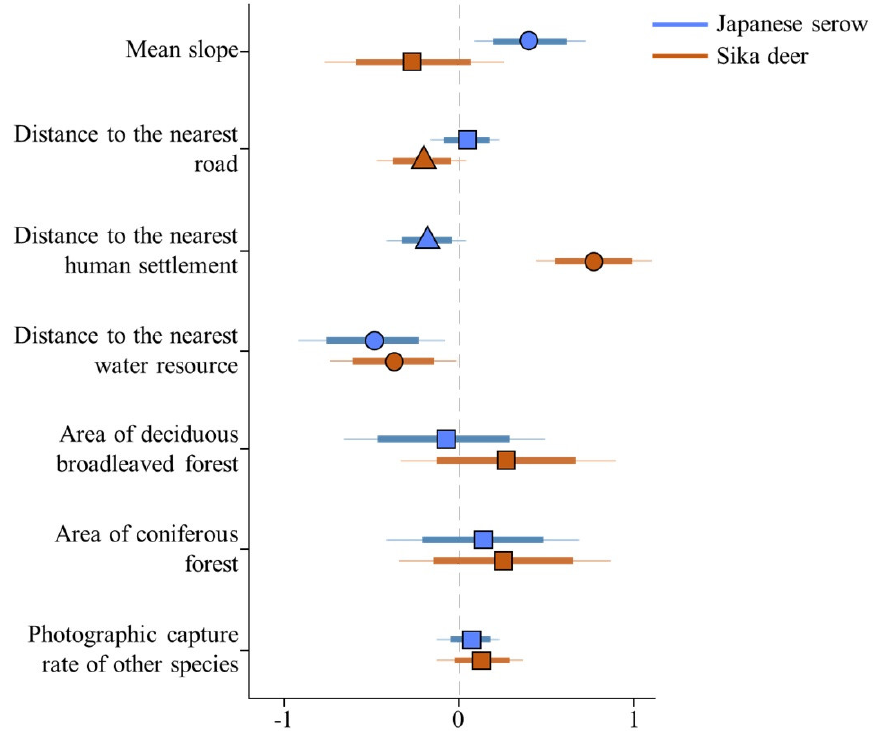
Figure 3. Posterior distribution of the parameters included in the occurrence model of Japanese serows and sika deer in Tsumagoi, central Honshu, Japan. Thin and thick lines represent the 95 and 80% credible intervals (CIs), respectively. Circles, triangles, and squares represent 95, 80 and <80% CI, respectively. Mean slope refers to the mean angle of terrain, and “other species” refers to the other (of the two) study species.